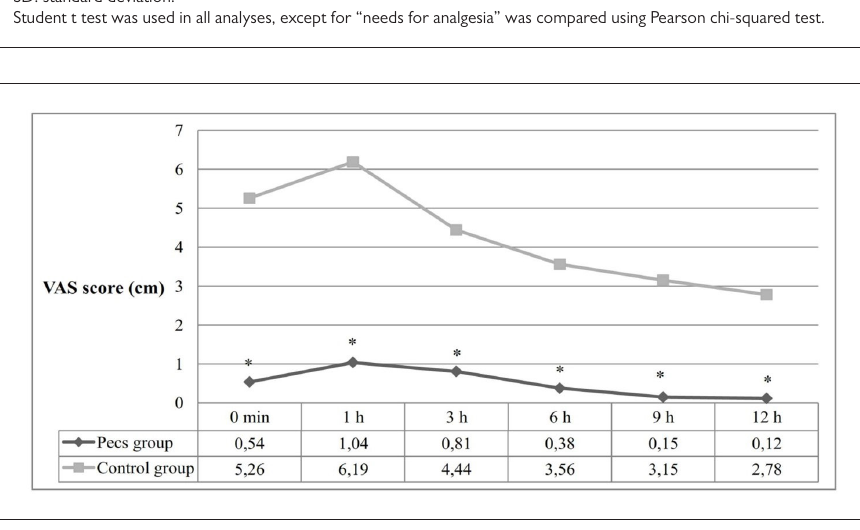
Pecs group (n = 26)